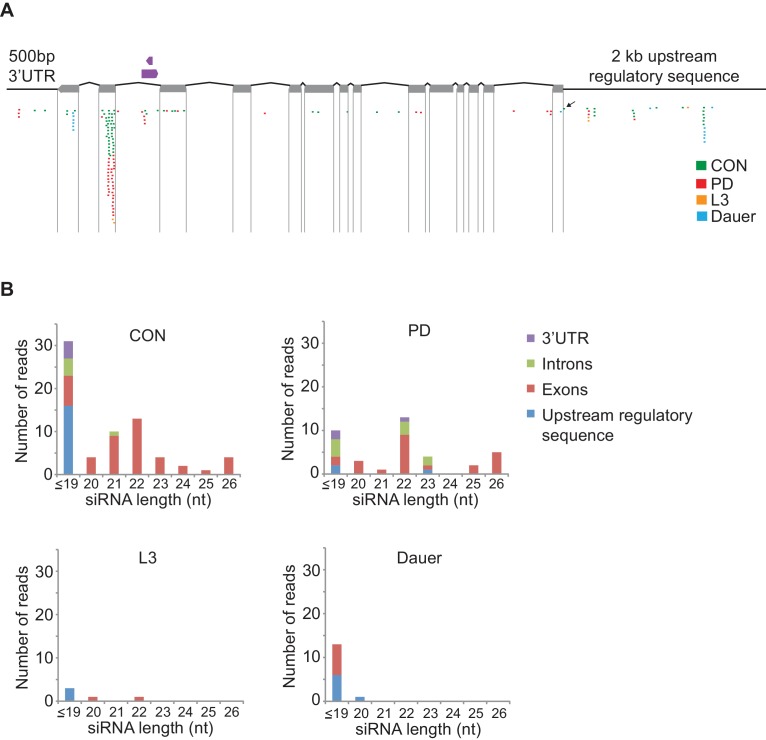
osm-9 siRNAs map predominantly to exons.(A) Schematic of osm-9 gene and regulatory regions. Exons are indicated by gray boxes. A tRNA (B0212.t1) and a non-coding RNA (B0212.7) are located in intron 12 of the osm-9 locus (shown in purple). SiRNAs were sequenced from CON, PD, L3, and dauer whole animals in previous work (Hall et al., 2013); those sequences mapping to the osm-9 locus are indicated (Figure 4—figure supplement 2—source data 1). The black arrow indicates the siRNA mapping to the PD motif. (B) Characterization of siRNA length and location mapping to the osm-9 locus for each developmental stage.DOI:
http://dx.doi.org/10.7554/eLife.11642.03010.7554/eLife.11642.031Figure 4—figure supplement 2—source data 1.Spreadsheet containing siRNA sequences mapping to the osm-9 locus for CON, PD, larval L3, and dauer small RNA libraries.